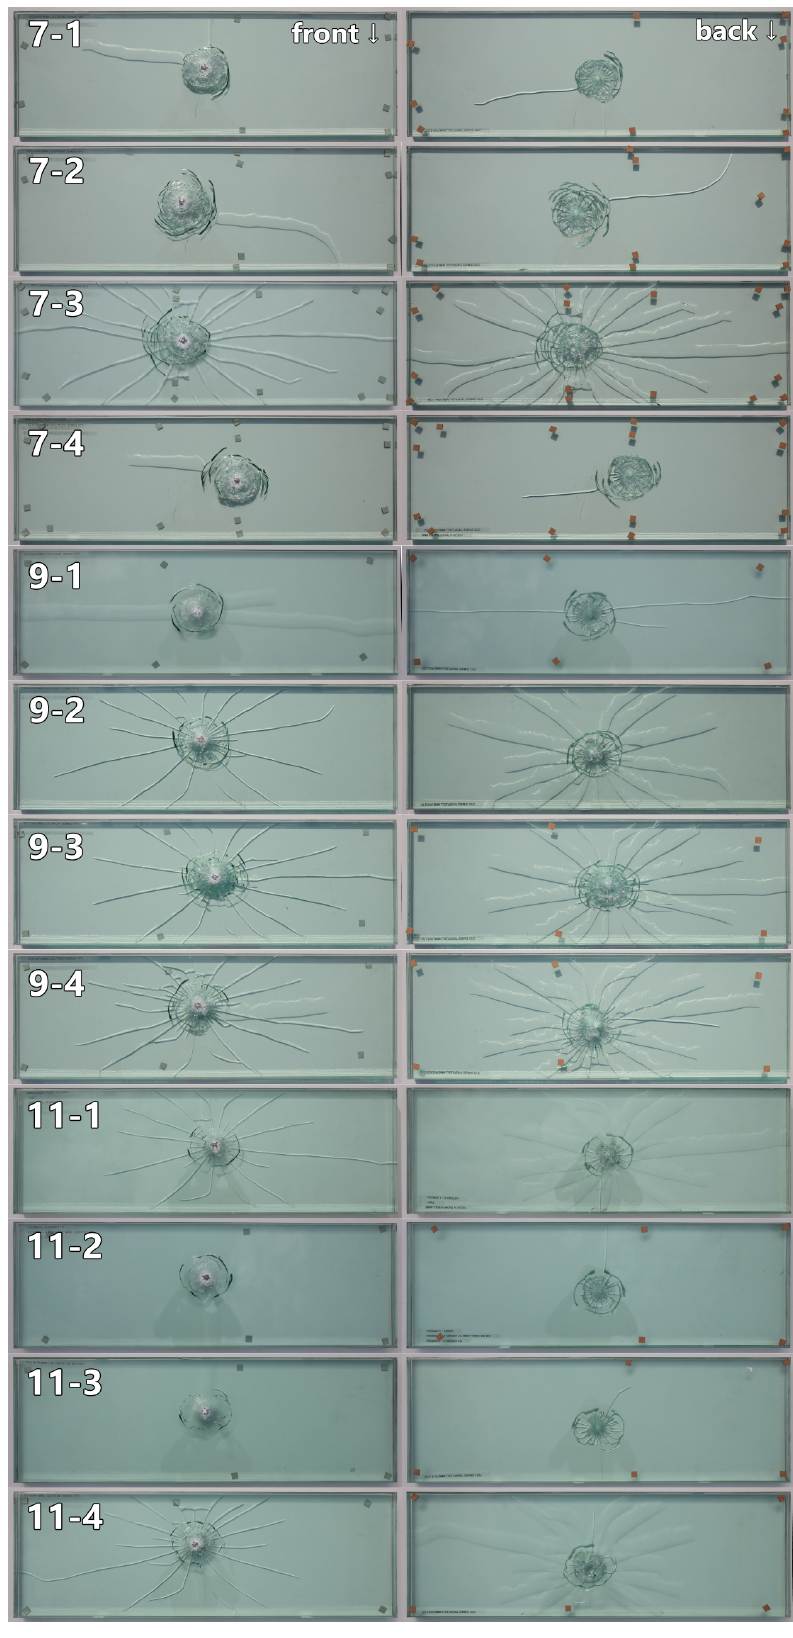
Figure A2. Specimens after impact